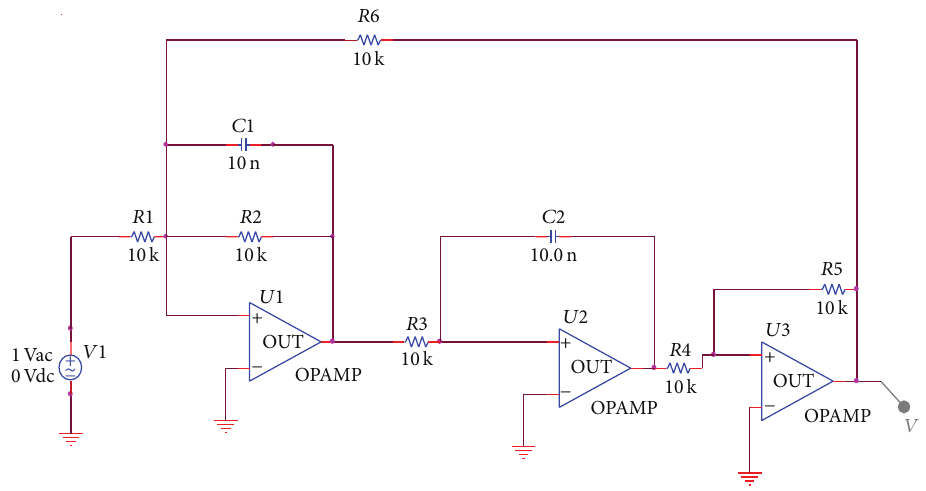
Figure 3: Two-Thomas filter